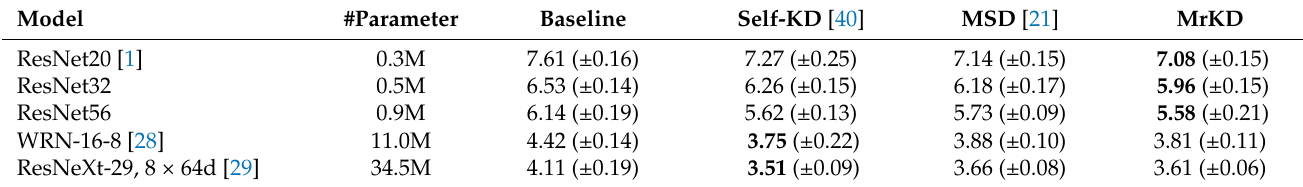
Table 6. Test error rate comparison on the CIFAR-10 [26] dataset (mean( ± standard deviation), in